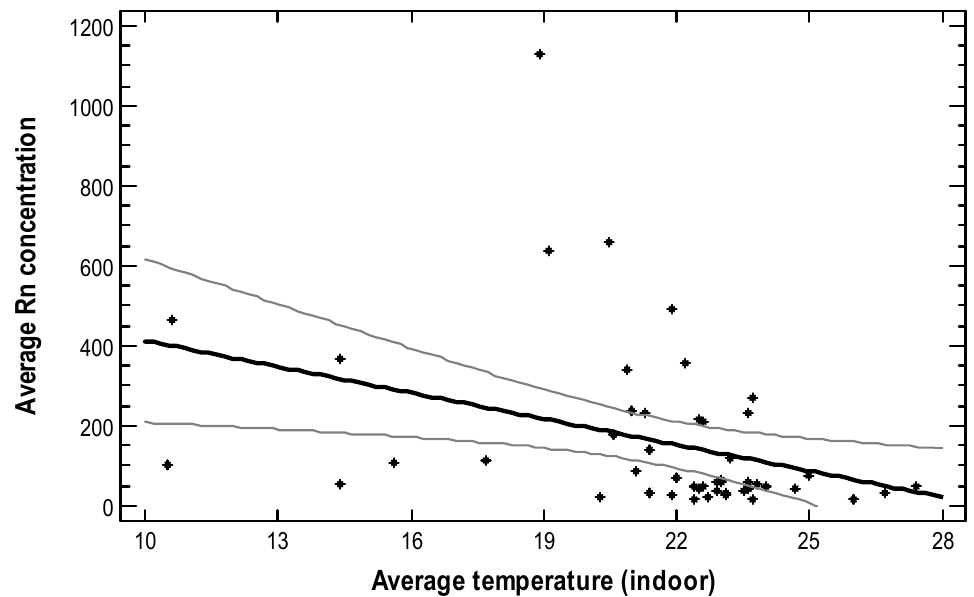
Figure 7. Plot of the fitted model of simple regression of radon concentration on indoor air temperature: Y axis—average radon concentration in institution (Bq m − 3 ); X axis—average air indoor temperature (Celsius degrees); points—observations; bold line—regression line; thin lines—95% confidence level area.